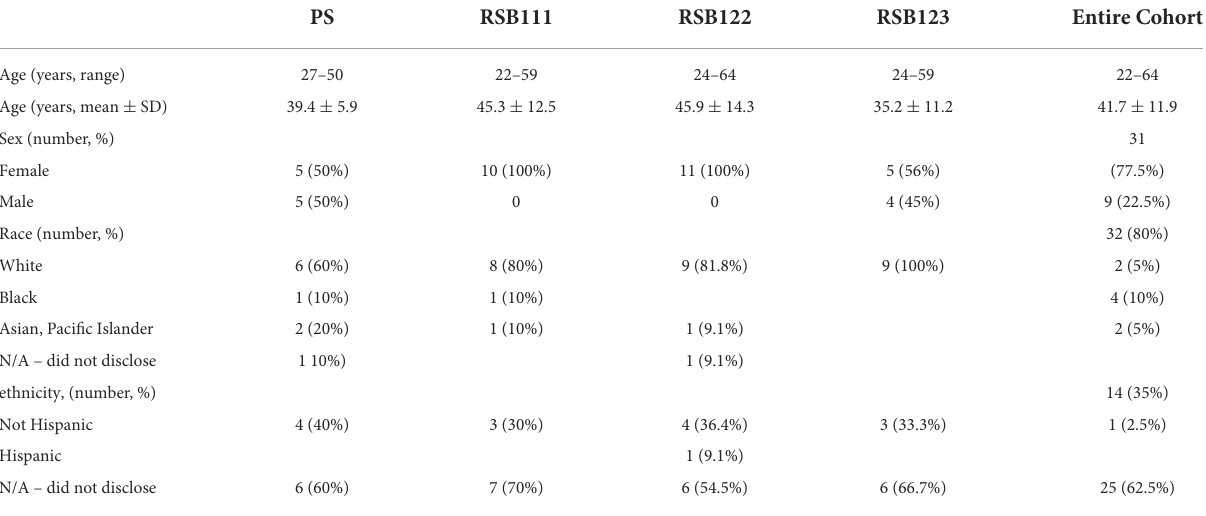
TABLE 1 Baseline characteristics of the study